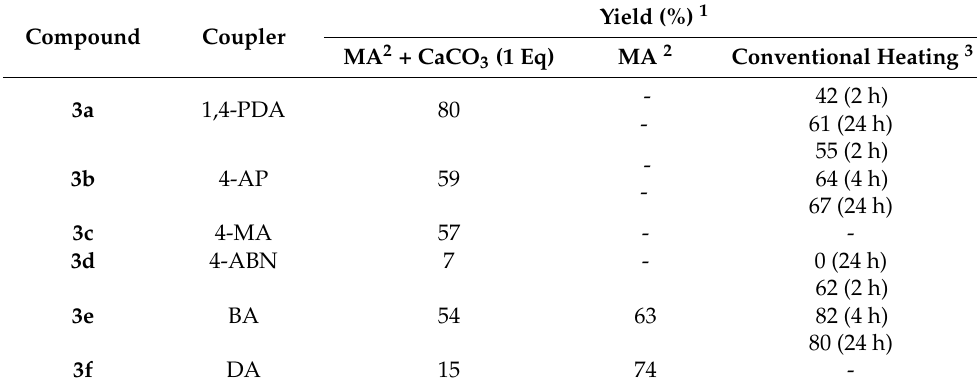
Table 2. Reaction yields of 2- N -arylamino-1,4-NQ derivatives ( 3a – 3f ) and N -alkylamino-1,4-NQ derivatives ( 3e,f ) synthetized by conventional heating and MA protocols.